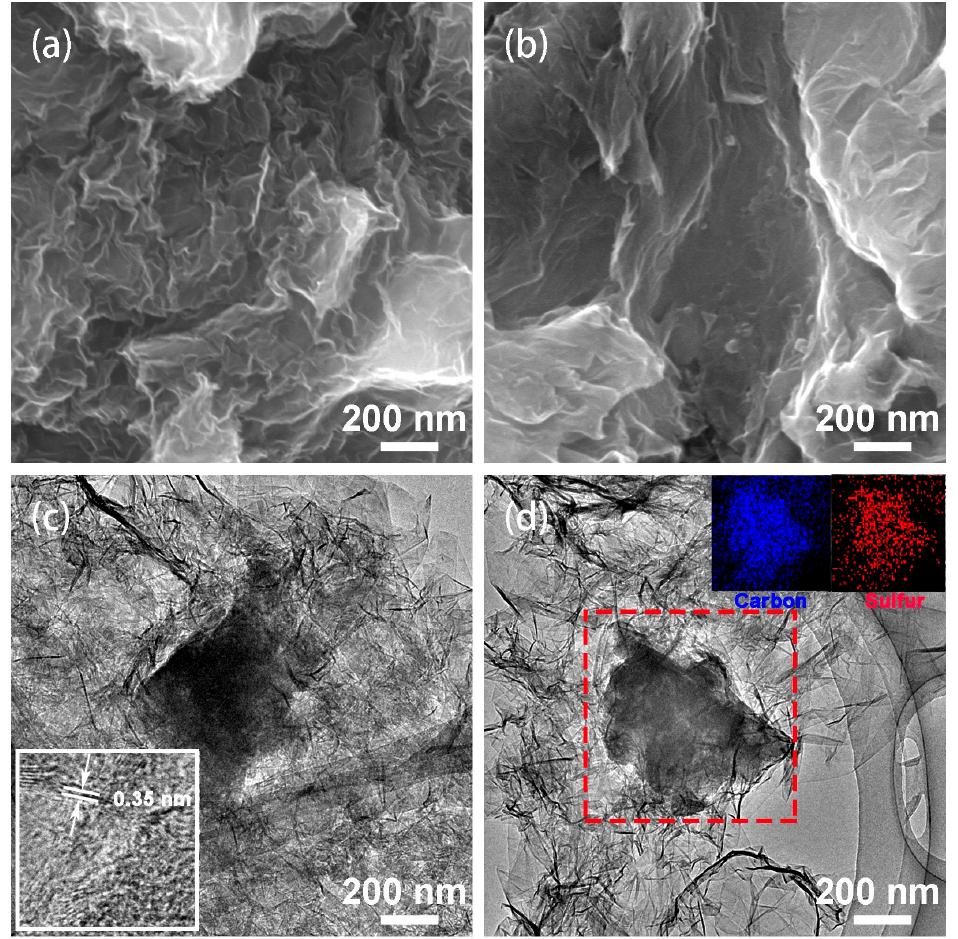
Figure 6. SEM images of AC/GA ( a ) and S/AC/GA composites ( b ), and transmission electron microscopy (TEM) images of AC/GA ( c ) and S/AC/GA composites ( d ); Inset of ( c ) is high-resolution transmission electron microscopy (HRTEM) of S/AC/GA composite; Insets of ( d ) is elemental (carbon, sulfur) mapping of S/AC/GA composite.